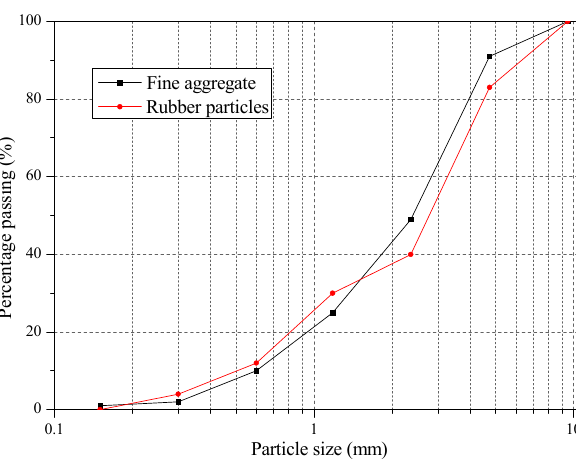
Figure 1. Particle size distribution of fine aggregate and rubber particles.